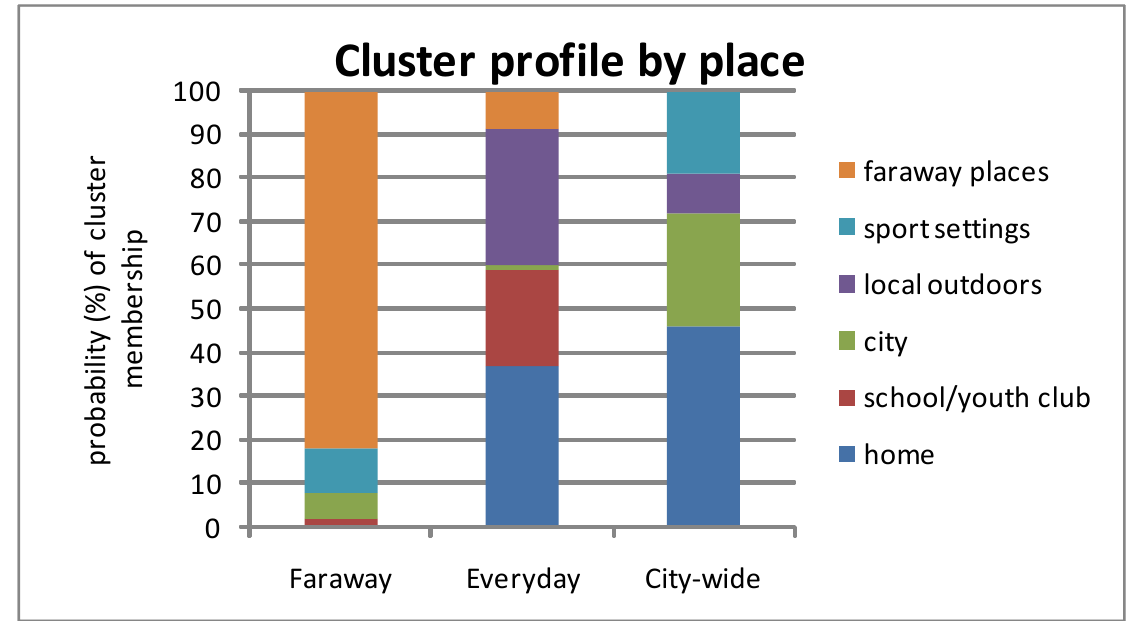
Figure 2. Cluster membership based on project place.